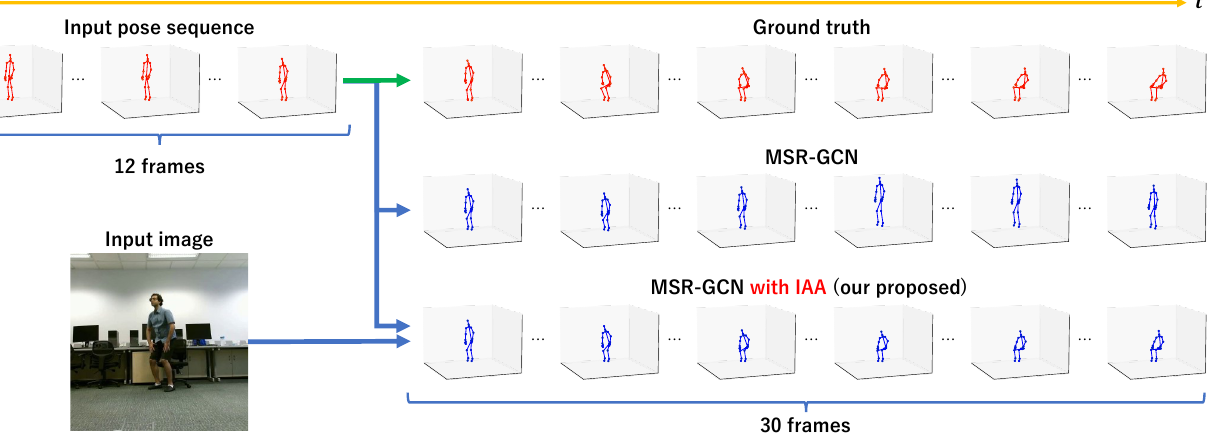
Figure 8. An example of predicted result (blue) and ground truth (red) in the “sit down” action. We can see that the predicted skeletons of MSR-GCN with IAA (with 2 FC layers) are closer to the ground truths when using the image of the surroundings.